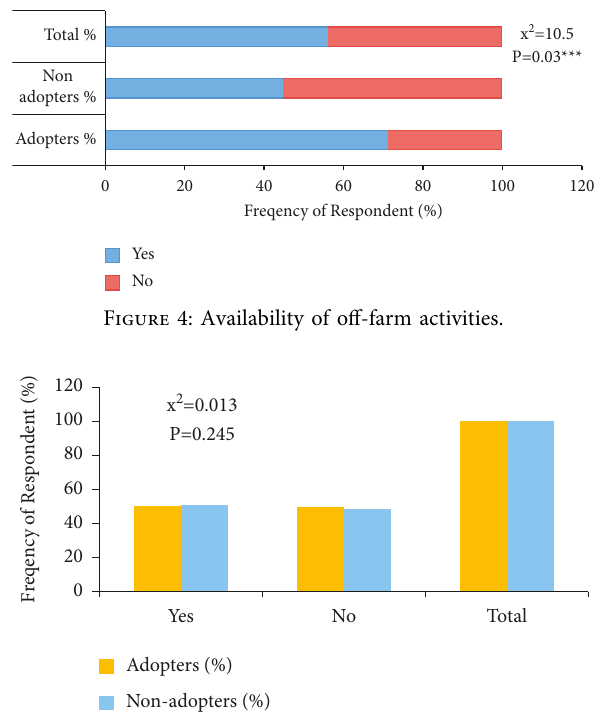
Figure 5: Ownership of a mobile telephone (not significant; (source: own survey result, 2019)).